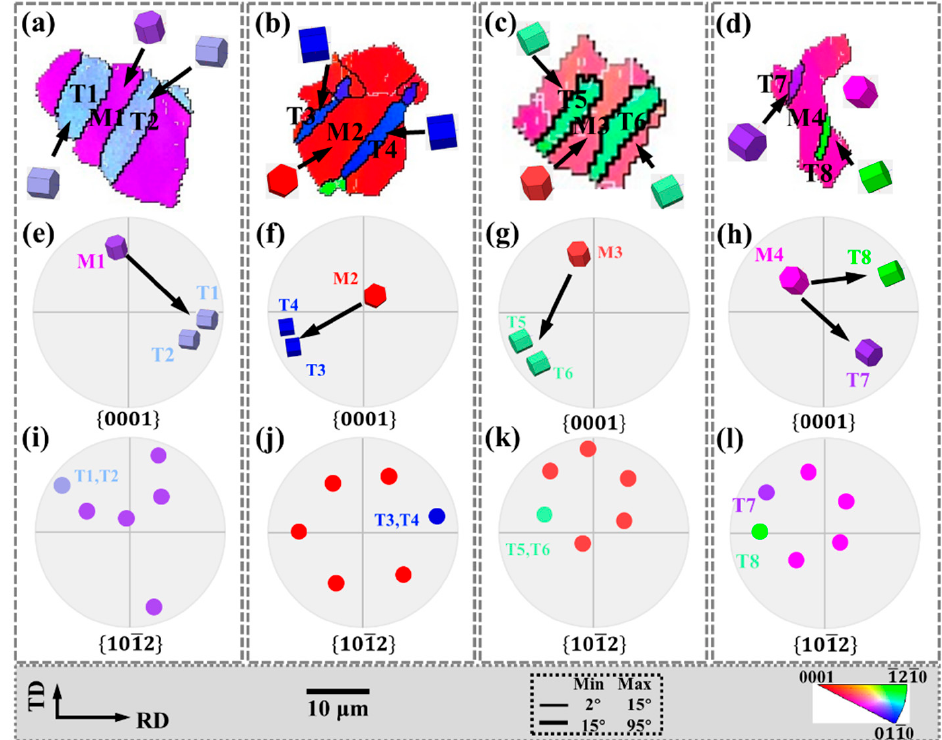
Figure 7. Parallel twin of the red circle region in Figure 4: ( a – d ) the IPF, ( e – h ) {0001} pole figure and ( i – l ) 1012 pole figure.